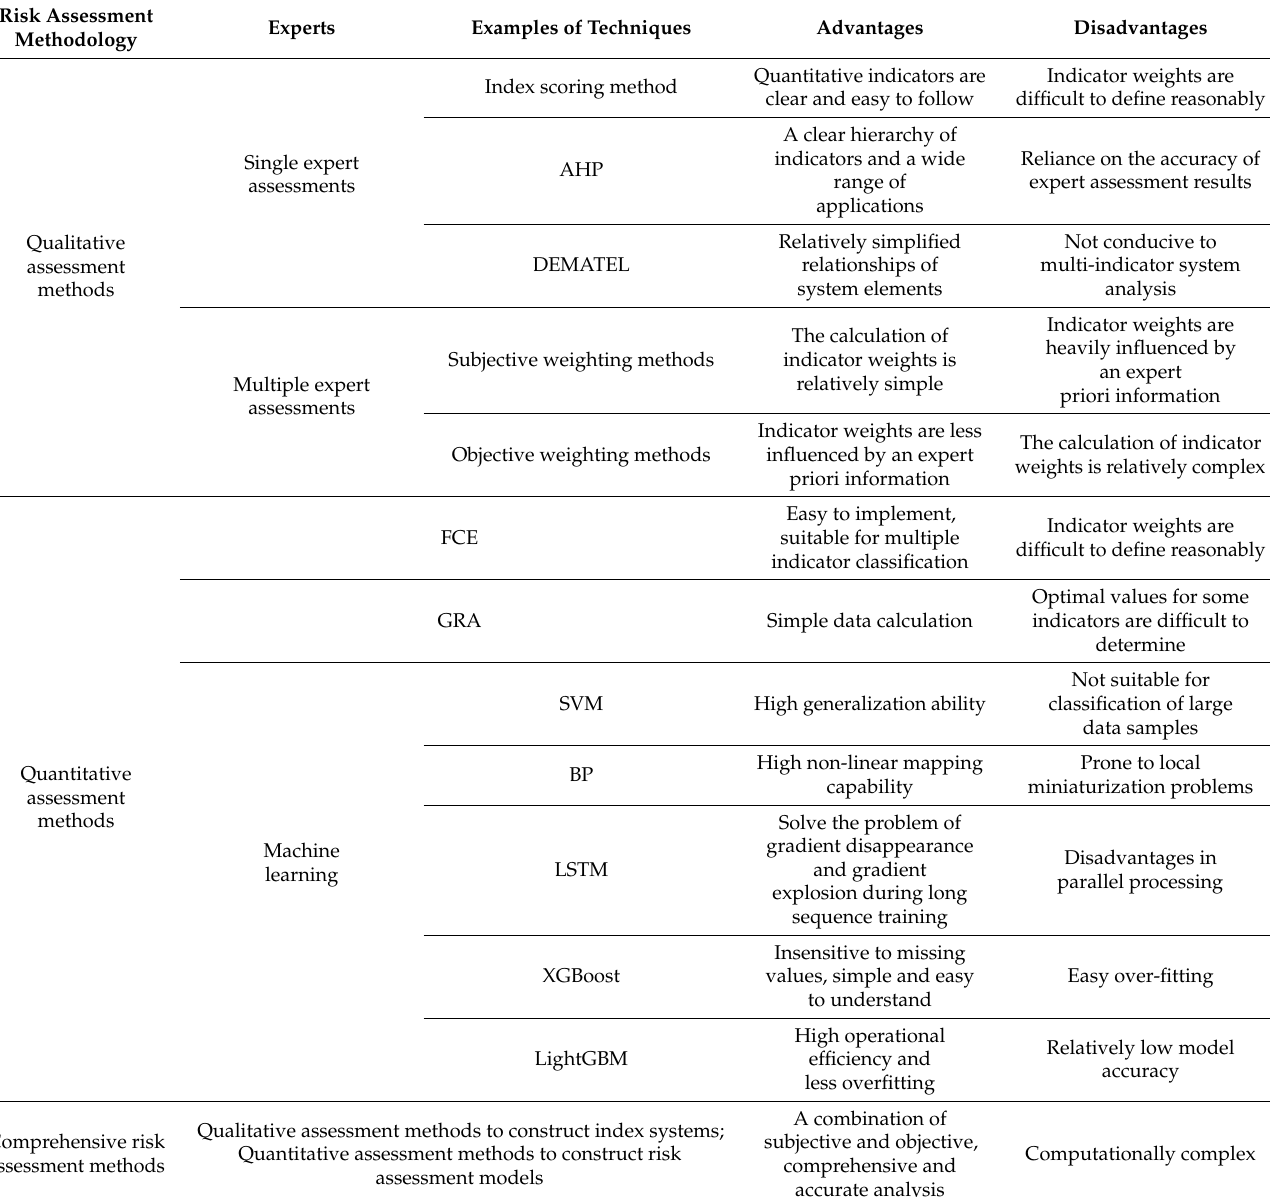
Table 1. Comparison of the advantages and disadvantages of mainstream risk assessment